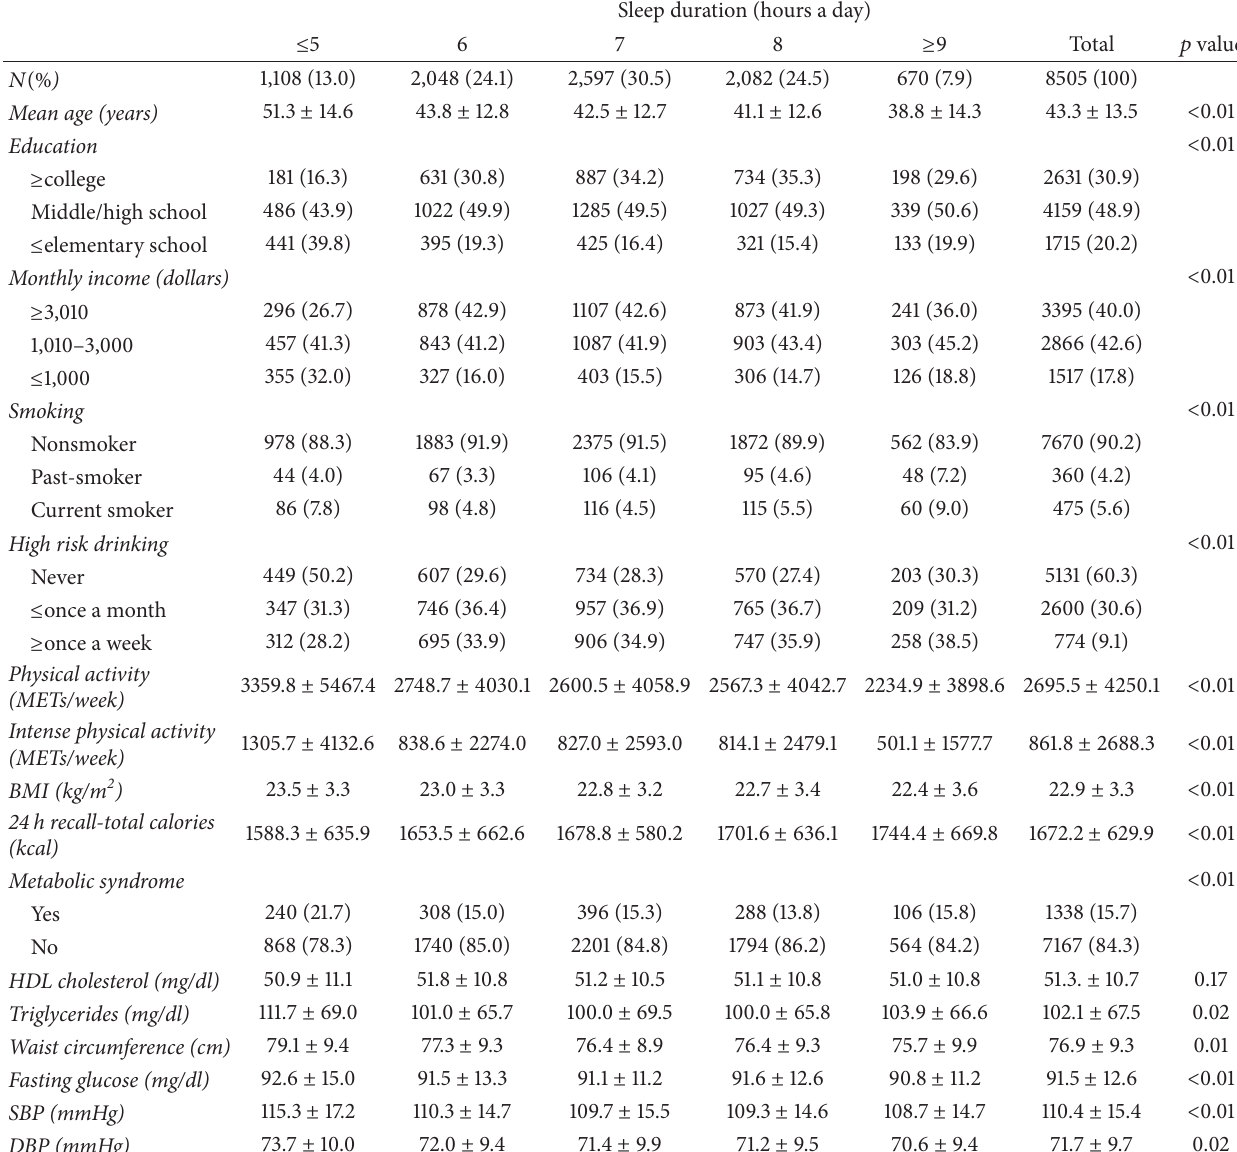
Table 1: General characteristics of participants according to sleep